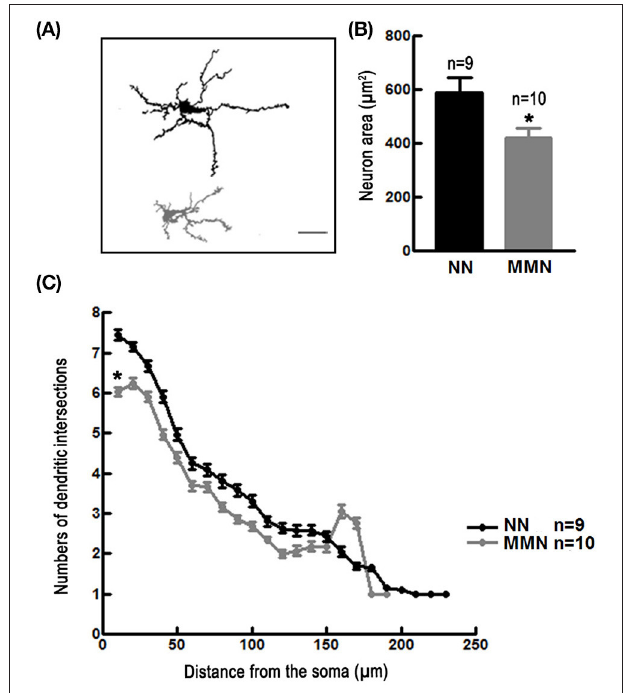
FIGURE 3 | (A) Representative camera Lucida drawings of Golgi-impregnated pyramidal neurons located in the dorso-medial cortex of an NN (upper panel) and of an MMN (lower panel) hatchling. Scale bar = 100 µ m. (B) Bar graph depicting the average total area of pyramidal neurons located in the dorso-medial cortex of hatchlings that emerged from NN or MMN [Nested ANOVA F (1, 13) = 11.99, * p = 0.004]. (C) Graph depicting the average number of dendritic intersections relative to the distance from the geometric center of the cell soma of pyramidal neurons of the dorso-medial cortex in NN and MMN hatchlings [Nested ANOVA Wald χ 2 (108) = 539.90, p < 0.001].